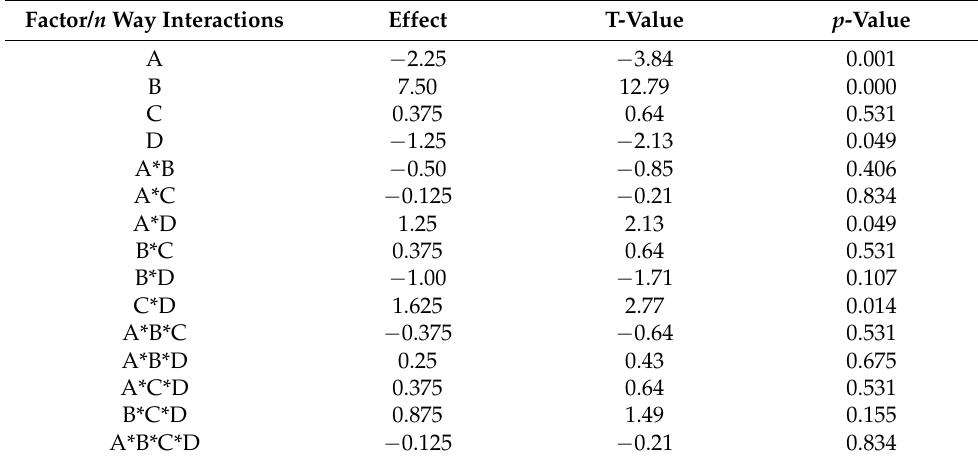
Table 4. Non-standardized effects, T- and p -values in factorial design. Factor/ n Way Interactions Effect